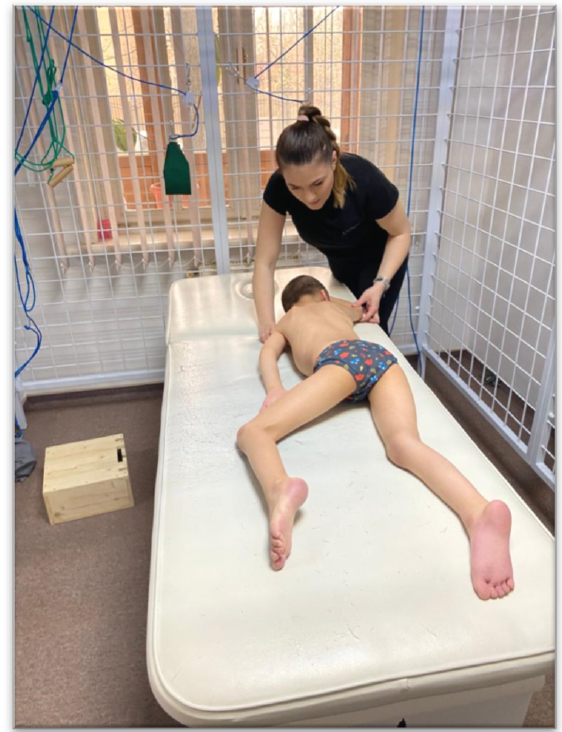
Figure 3. Reflex Figure 3. Reflex crawling.